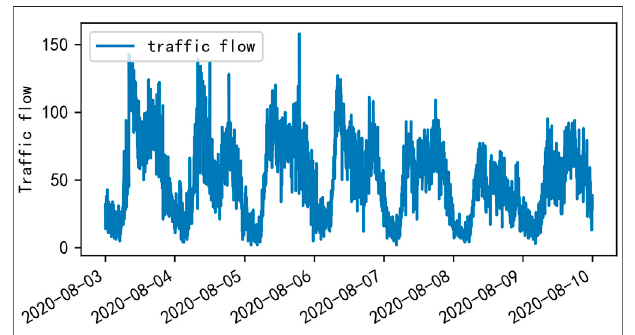
FIGURE 2 | Visualization of traf fi c fl ow in 1 day at the Yile intersection of Wenyi